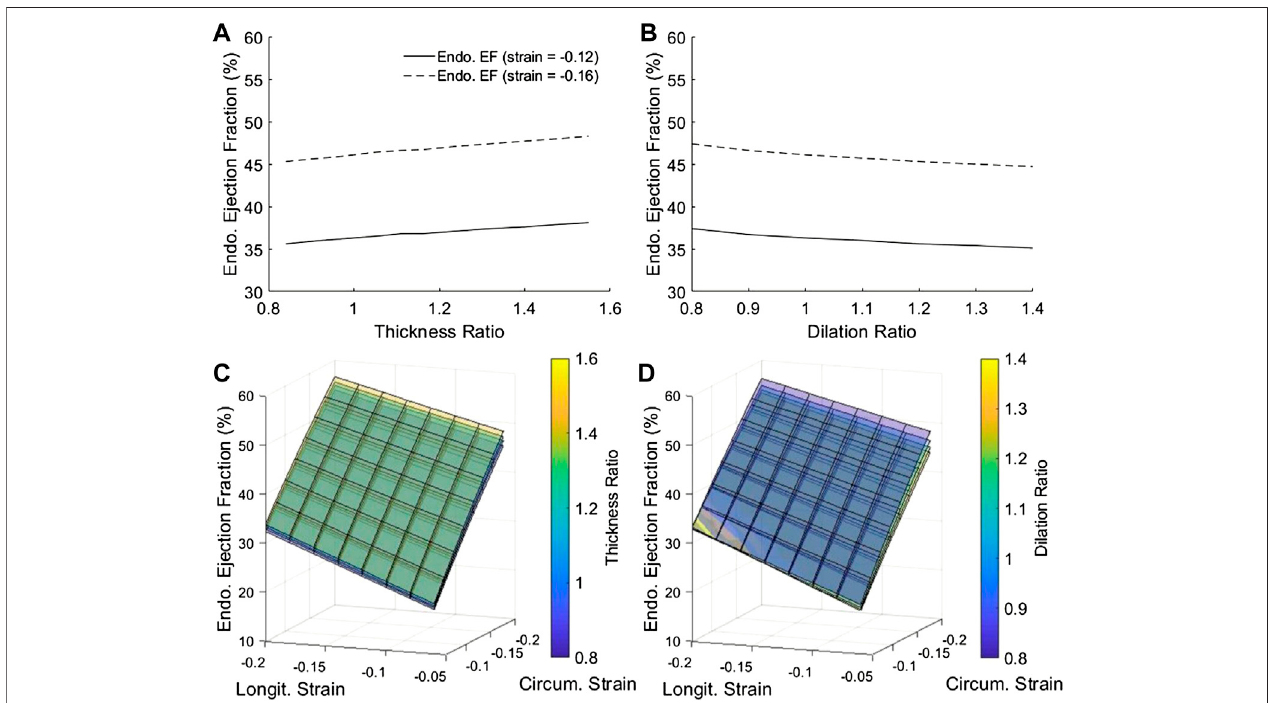
FIGURE 7 | After removing radial strain from our numerical model, endocardial EF became largely insensitive to geometric changes, in contrast with results in Figure 3 , demonstrating that radial displacement was the mechanism for endocardial EF shifting with geometry changes. (A,B) The dependency of endocardial EF on (A) myocardial thickness ratio and (B) chamber dilation ratio, when longitudinal and circumferential strains at the mid-wall layer were fi xed at either − 0.12 or − 0.16, and whenradialstrainwas0. (C – D) ThecompletedependencyofendocardialEFonthicknessratio,dilationratio,andlongitudinalandcircumferentialstrainsatthemid- wall layer.